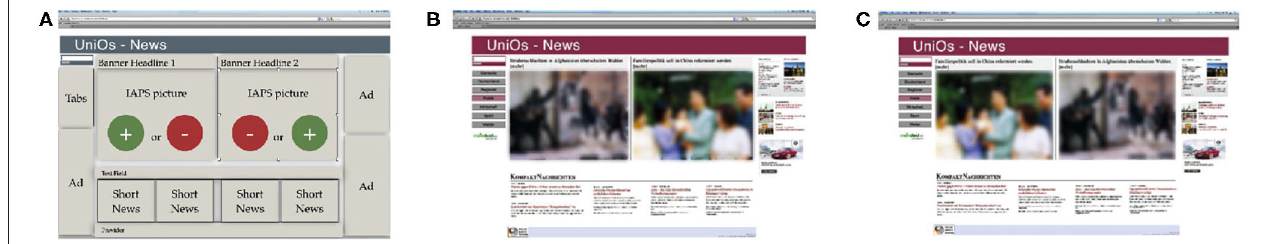
FIGURE 1 | Web pages used in the study. (A) Prototype web page with different sections: headlines, adds, tabs, news, and images. (B) Example of a web page with a negative image on the left side. (C) Example of a web page with a negative image on the right side [reverse of (B) ].